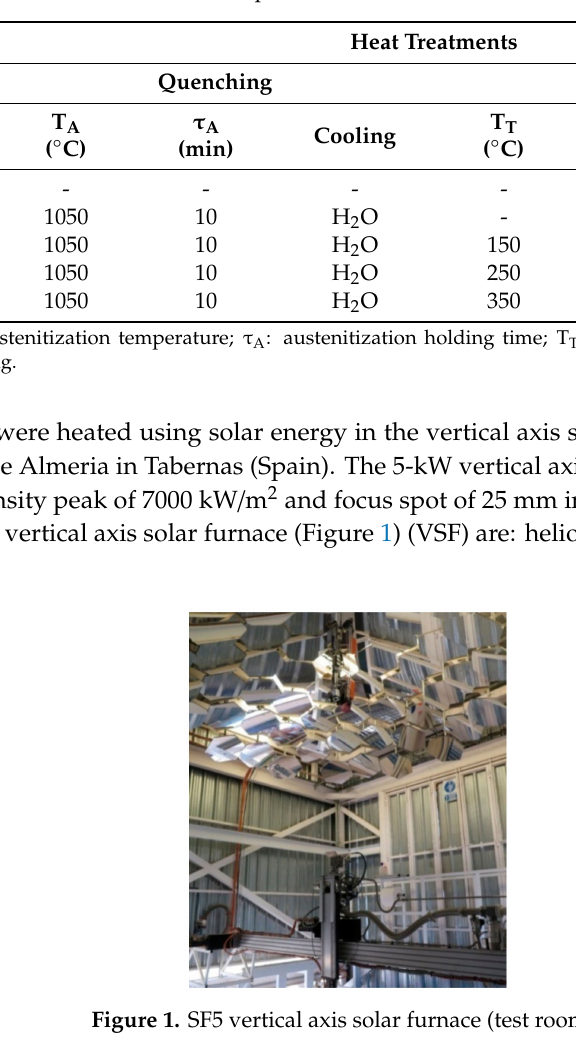
Table 2. Heat treatment parameters for modified 316 AISI samples.